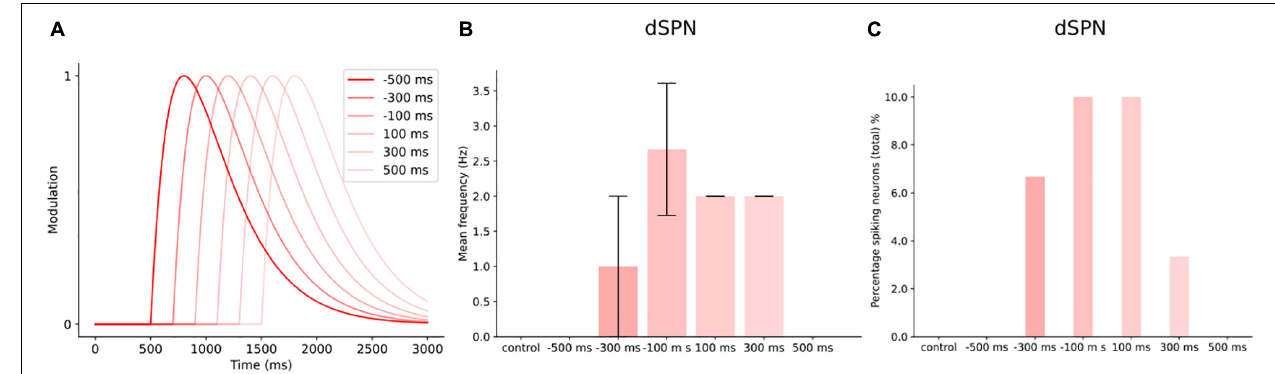
FIGURE 10 | Timing of dopamine signal with cortical input in a small network of dSPNs. (A) Different delays in the dopamine transients with cortical input at 1000 ms, for 500 ms. (B) The mean frequency of dSPNs following the different DA delays. In control (without dopamine modulation), the dSPNs within the network do not spike following cortical activation. Dopamine modulation starts at 500 ms before cortical input (–500 ms), does not produce enough modulation to induce spiking. While –300 ms, increases the mean firing frequency and the following delays except 500 ms. (C) The percentage of spiking neurons within the network at different dopamine delays. At 300 ms, the percentage of spiking cells was 7%. –100 and 100 ms produced a similar effect on the number of spiking neurons within the network.